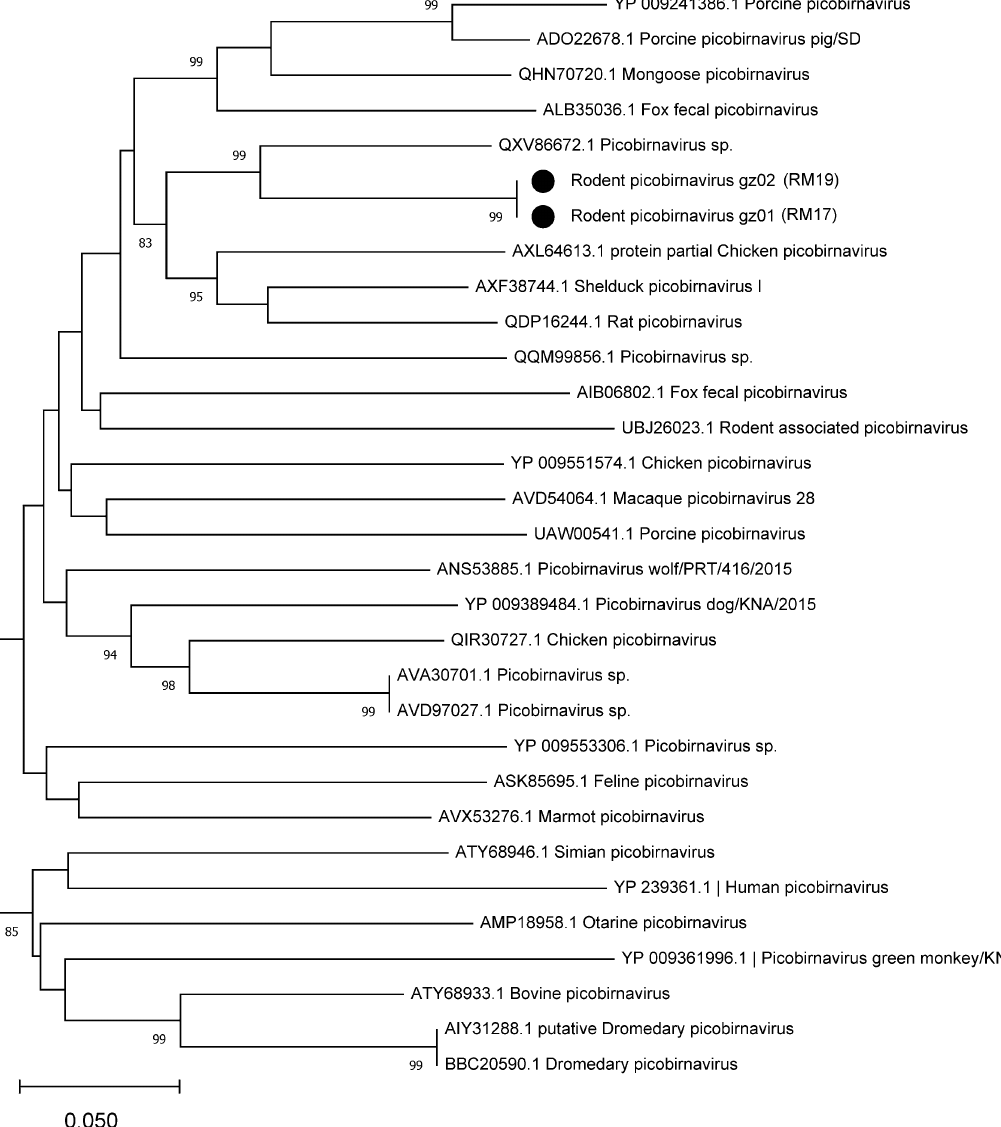
Figure 8. Phylogenetic analyses of picobirnavirus genomes on the basis of the segment 2 (RdRp) aa sequence. Branch lengths are drawn to a scale of aa substitutions per site. Numbers above individual branches indicate the bootstrap support, only values > 80% are shown. The novel variants of picobirnavirus are marked with a black dot, sample ID were labeled in